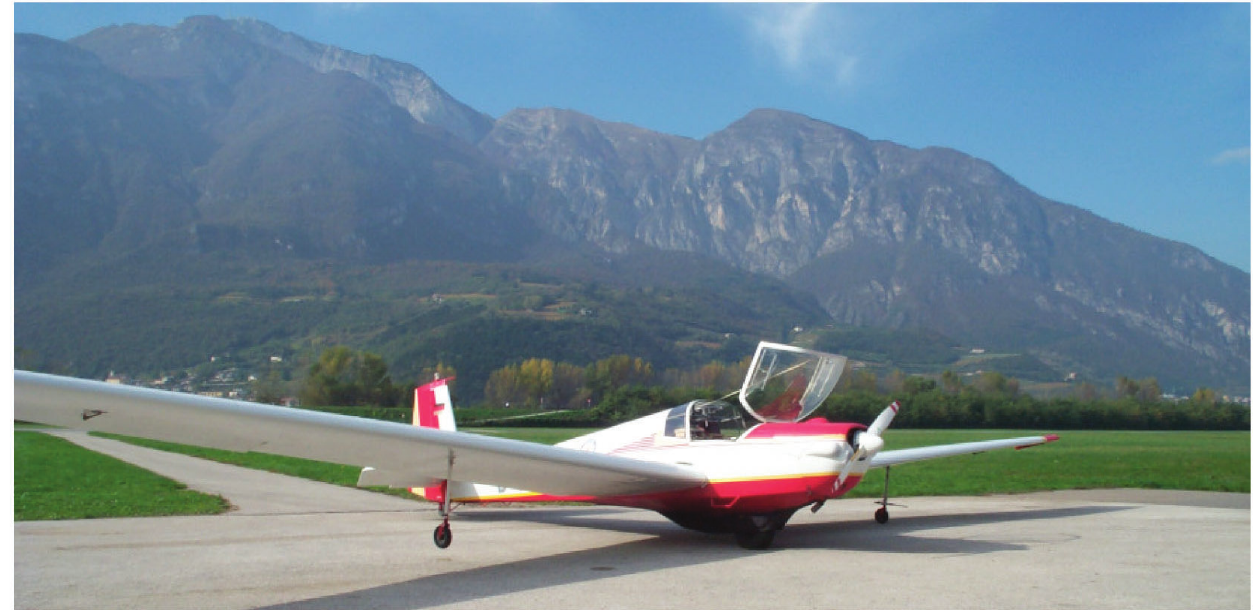
Fig. 2. The motorglider ready for take off at Trento